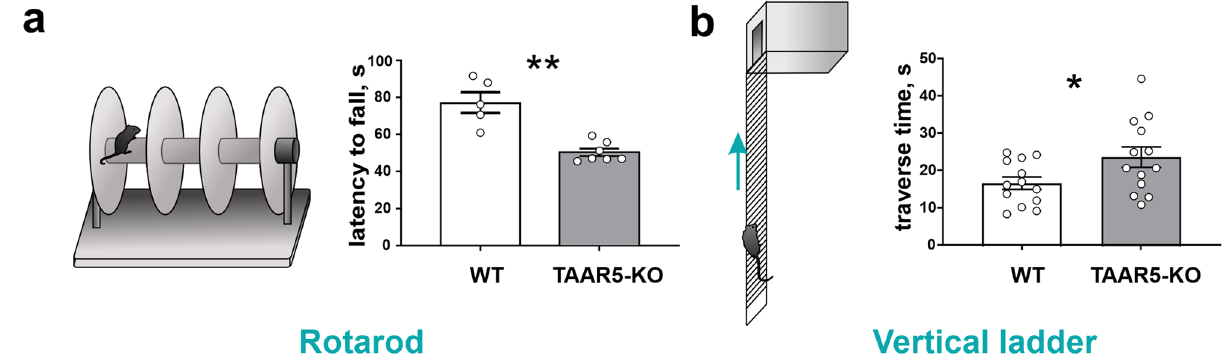
Figure 2. Behavioral testing of motor coordination, endurance, and muscle strength in TAAR5-KO and WT mice. ( a ) Latency to fall from the Rotarod. ( b ) Total time to climb on the Vertical Ladder. Values are presented as mean ± SEM, significance level *P < 0.05, ** P < 0.01.